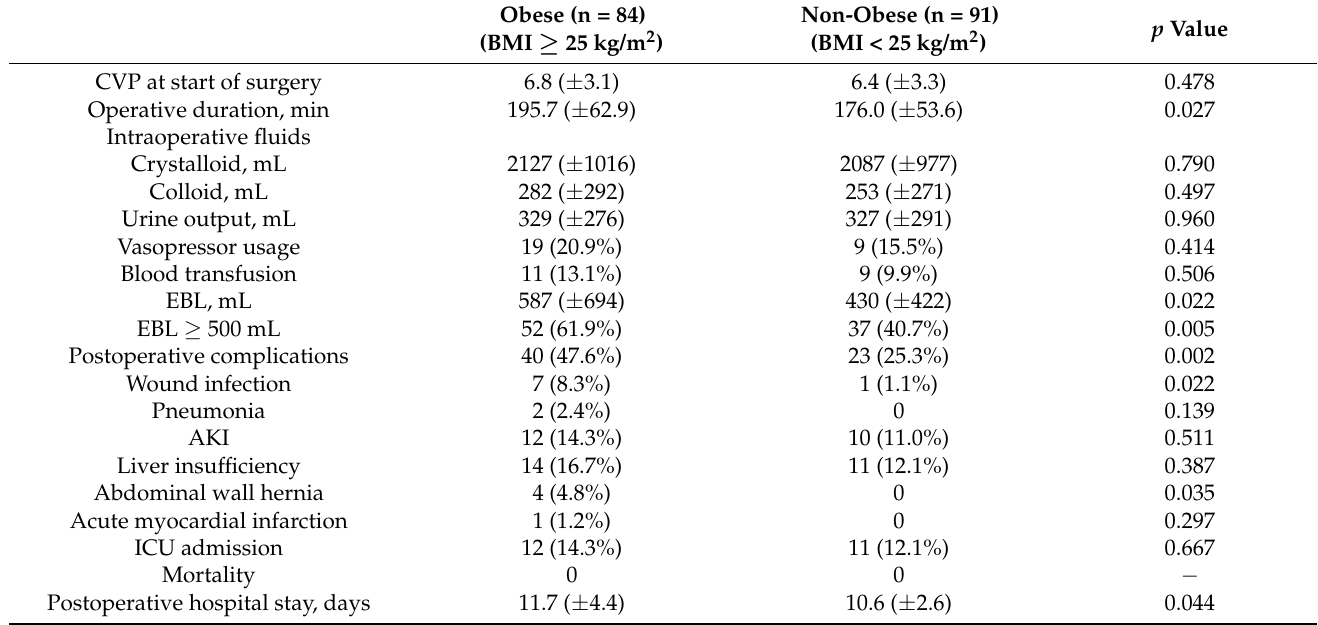
Table 2. Operative outcomes of